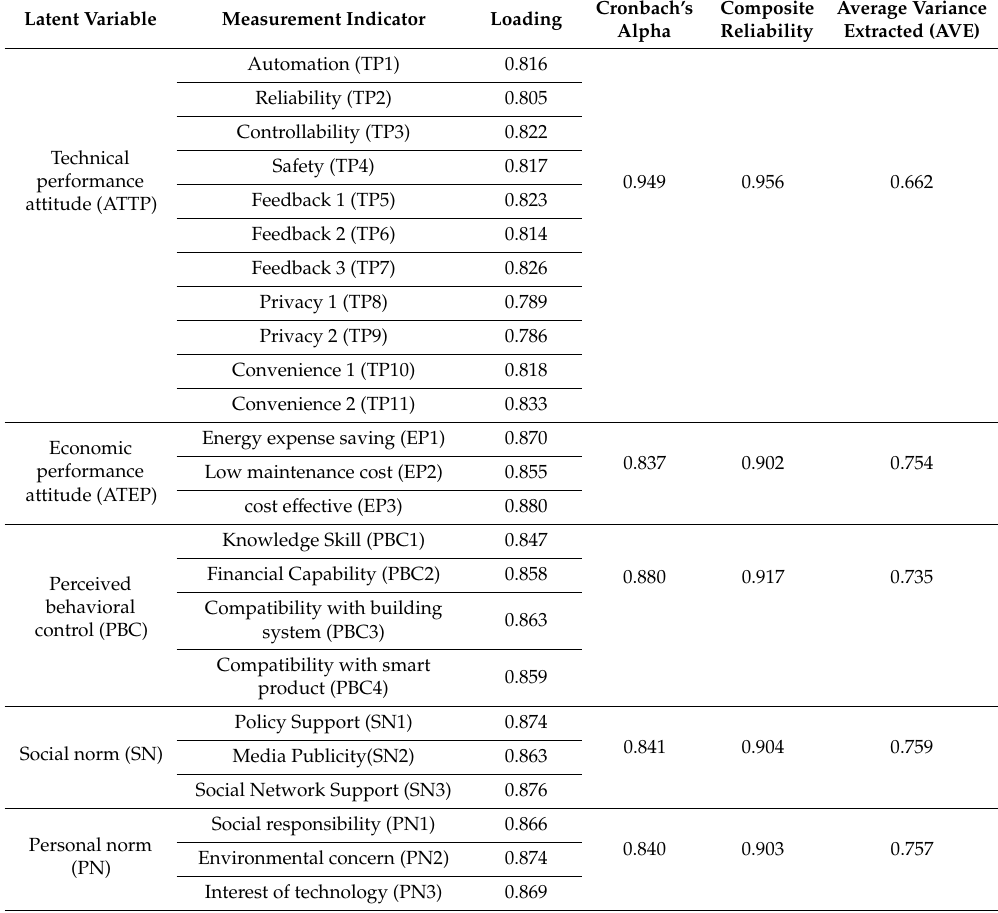
Table 5. Assessment of measurement model: convergent